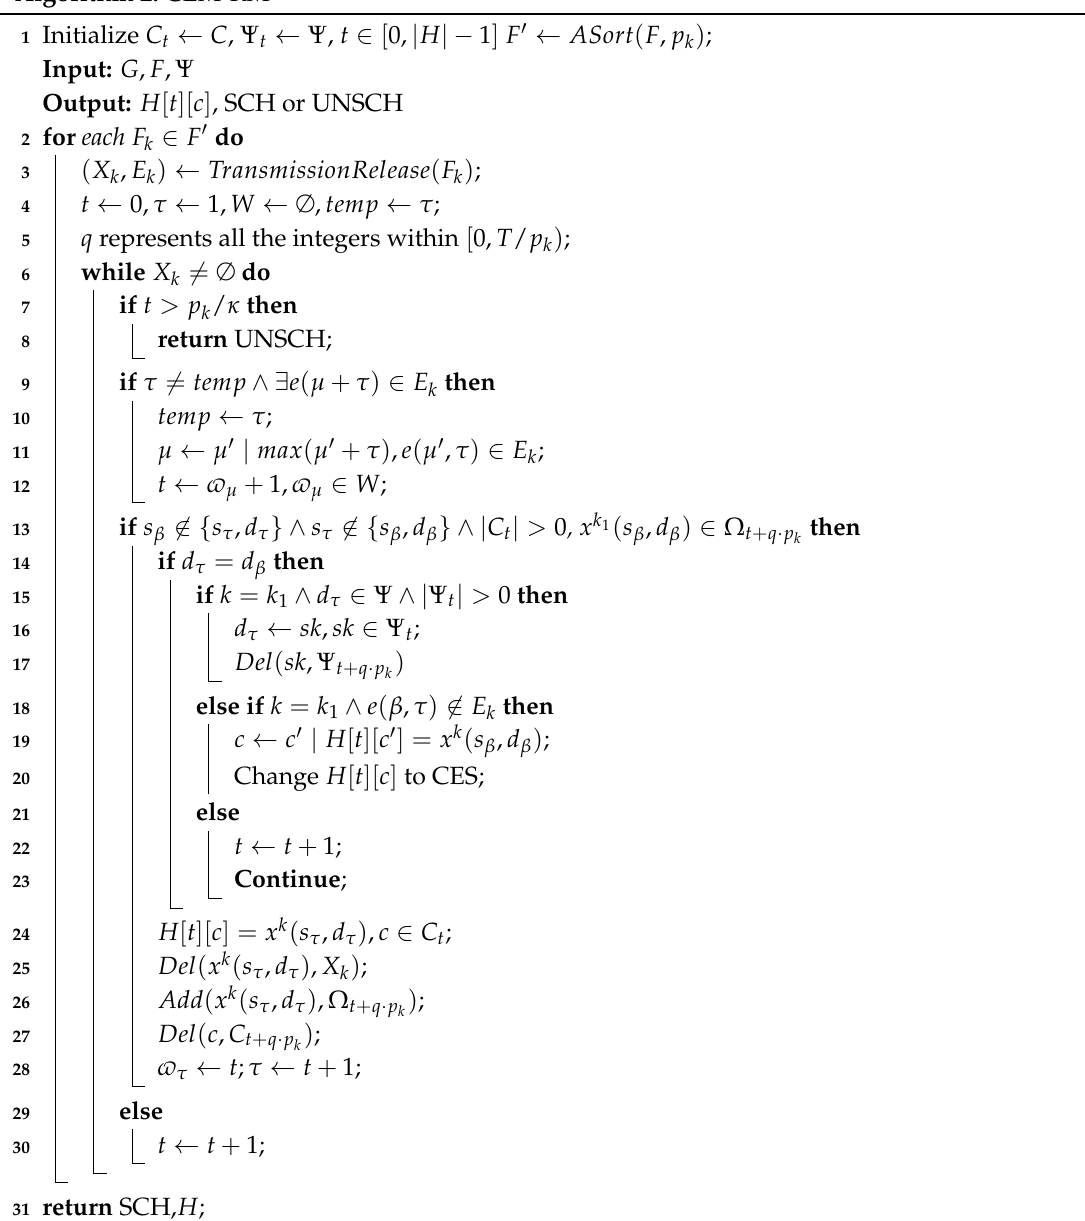
Figure 4. The communication resources for a hyperframe. Algorithm 2: